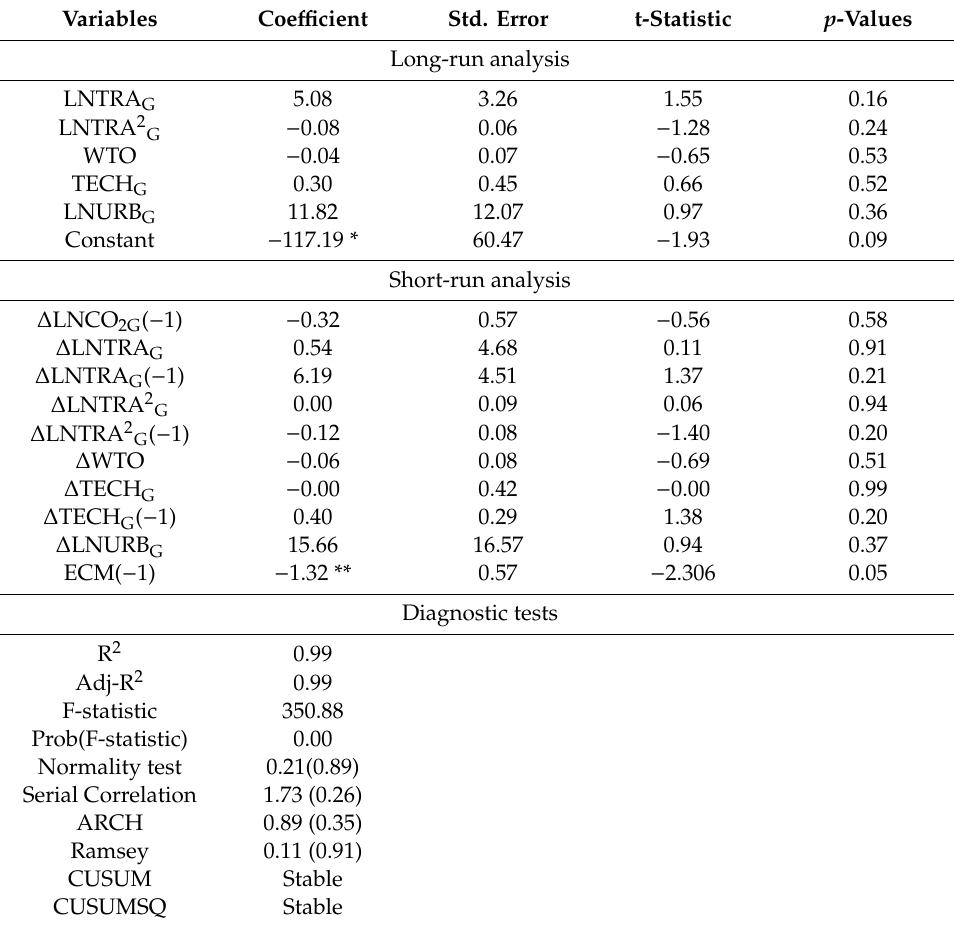
Table 13. Robustness analysis for Model 2.